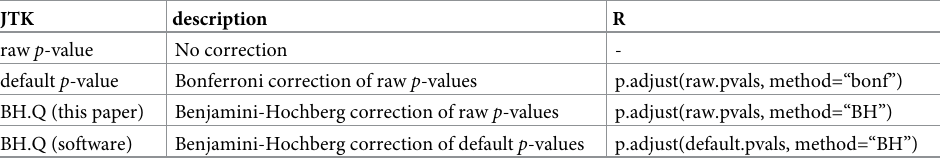
Table 1. Raw, default, and BH.Q in JTK